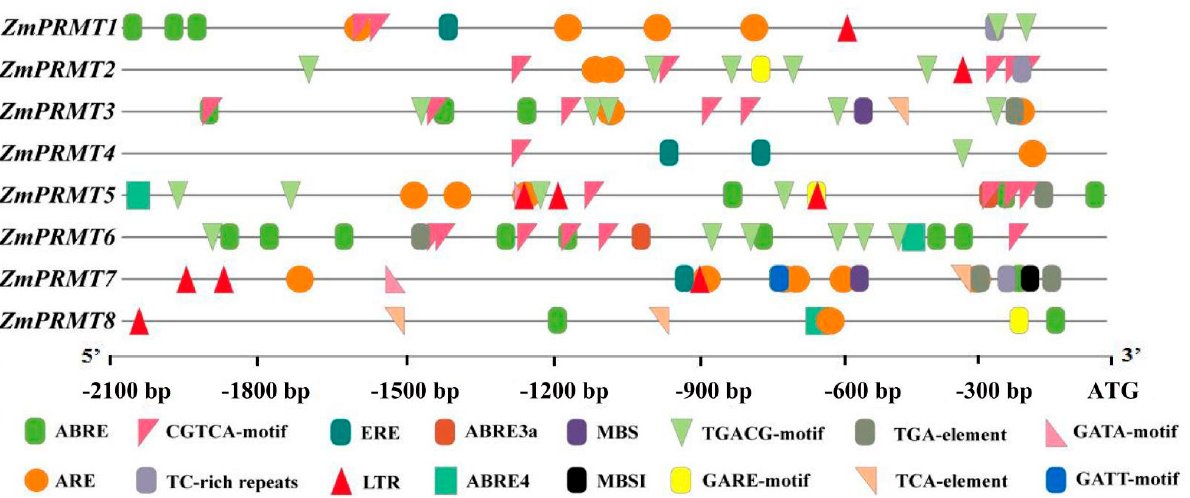
Figure 3. Distribution of major stress-related cis-elements in the promoter sequences of the 8 ZmPRMT genes. Putative ABRE, CGTCA-motif, ERE, MBS, TGACG-motif, GATA-motif, TGA-element, ARE, TC-rich repeats, LTR, GARE-motif, TCA-element and GATT-motif core sequences are represented by different symbols as shown in the symbols at the bottom. ABRE: cis-acting element involved in the abscisic acid responsiveness; CGTCA-motif: cis-acting regulatory element involved in the MeJA responsiveness; ERE: ethylene-responsive element; MBS: drought -responsive element; TGACG-motif: cis-acting regulatory element involved in the MeJA-responsiveness; GATA-motif: zinc-finger transcription factor; TGA element: auxin-responsive element; ARE: anaerobic-responsive element; TC-rich repeats: cis-acting element involved in defense and stress responsiveness; LTR: low-temperature relative element; GARE-motif: gibberellin-responsive element; TCA-element: cis-acting element involved in salicylic acid responsiveness. The position of each cis-element in the 2 kb sequence upstream of the initiation codon (ATG) of the ZmPRMT genes was measured at a scale of 300 bp.